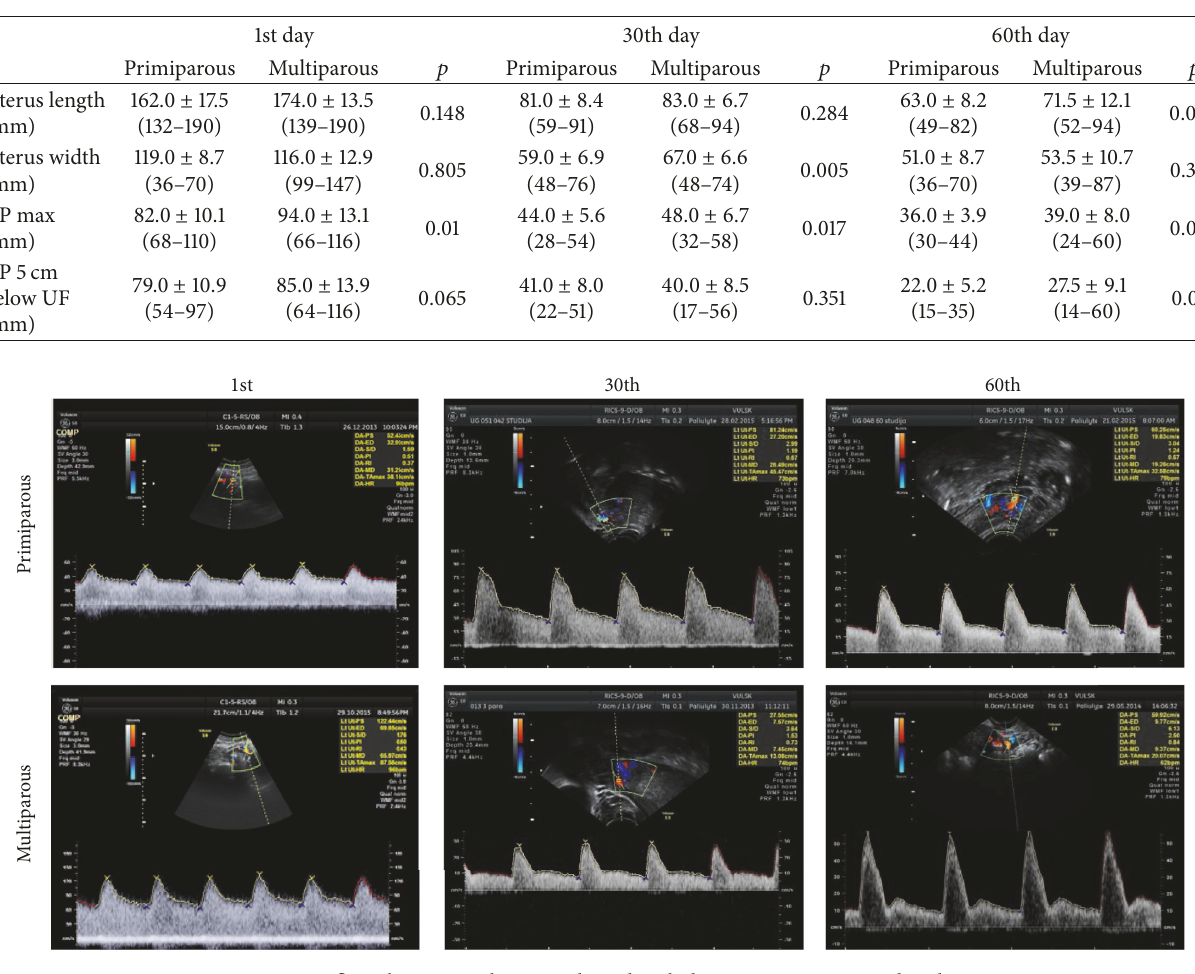
Table 2: Median characteristics ± standard deviation of the uterine size with minimum and maximum values (mm).